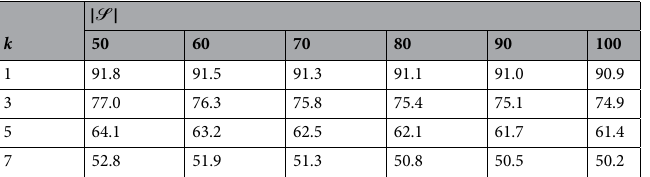
Table 2. Examples for probability p lo (in %) in dependence on the number of considered neighbors k and the dataset size | S | . The examples are based on 10-fold CV experiments.